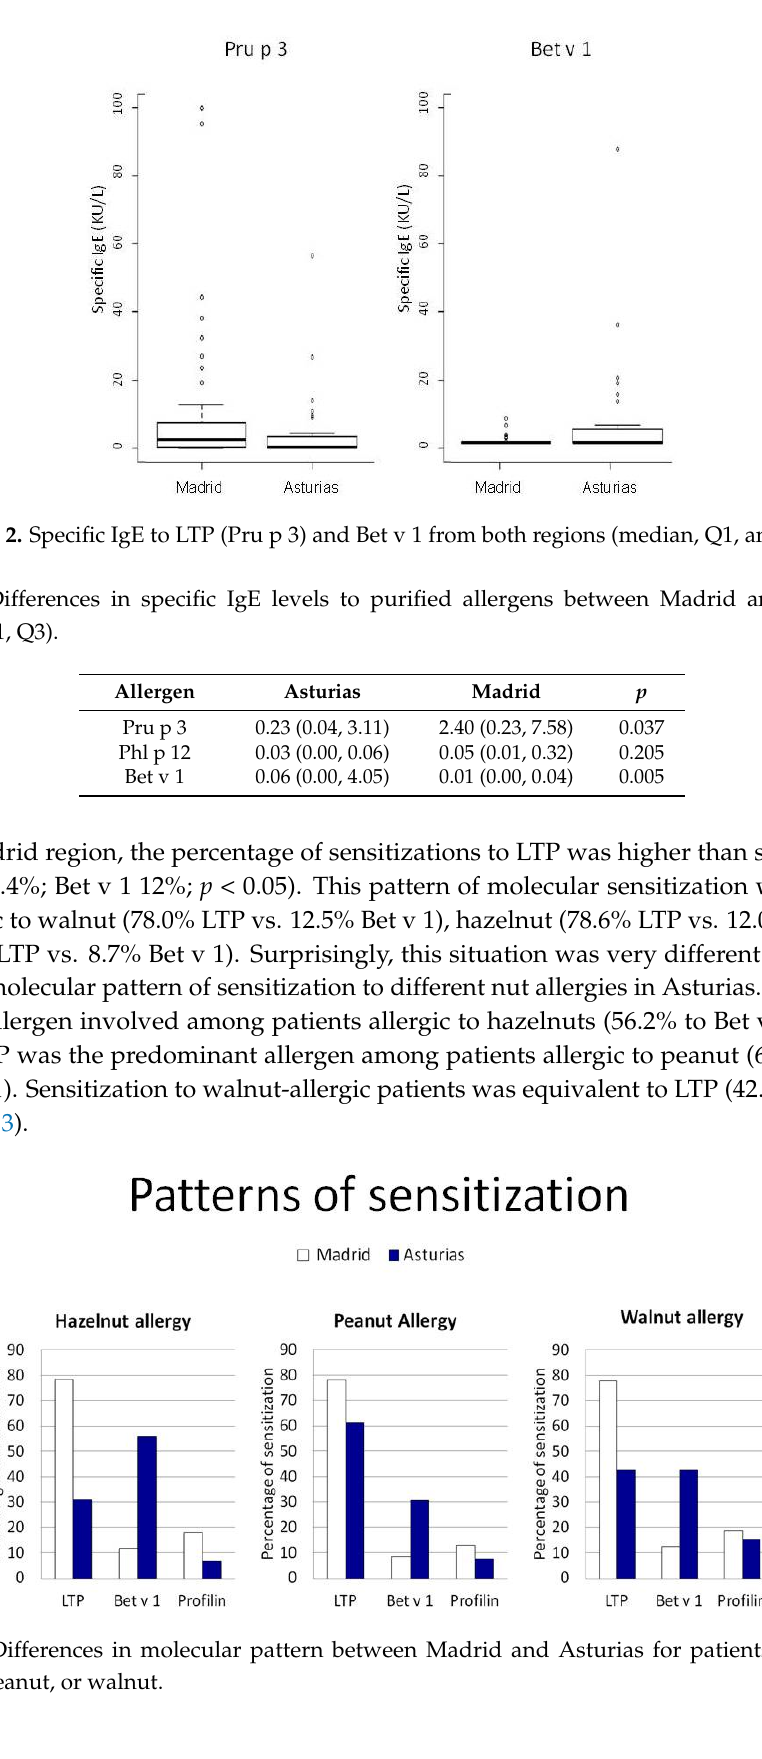
Figure 3. Differences in molecular pattern between Madrid and Asturias for patients allergic to hazelnut, peanut, or walnut.